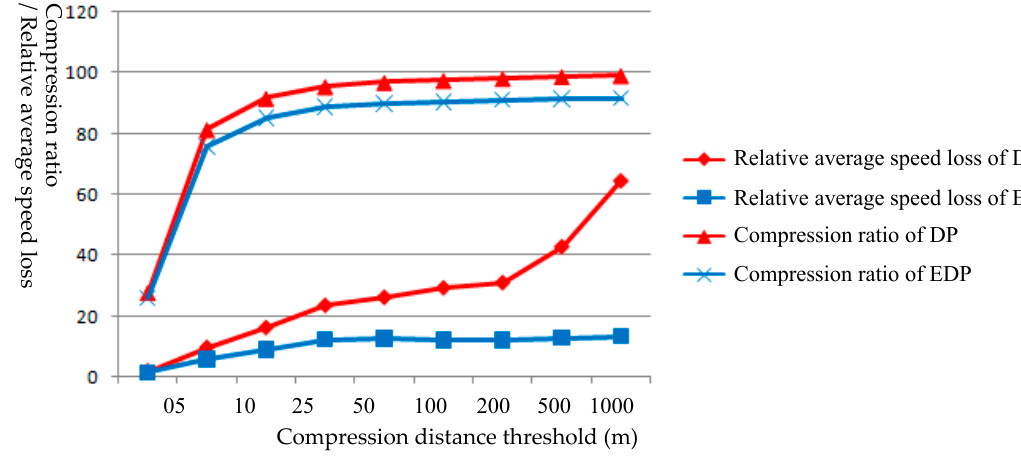
Figure 13. Relative average speed loss and compression ratio of DP and EDP algorithms in the post-simplification data of Trajectory 1 with different distance thresholds.